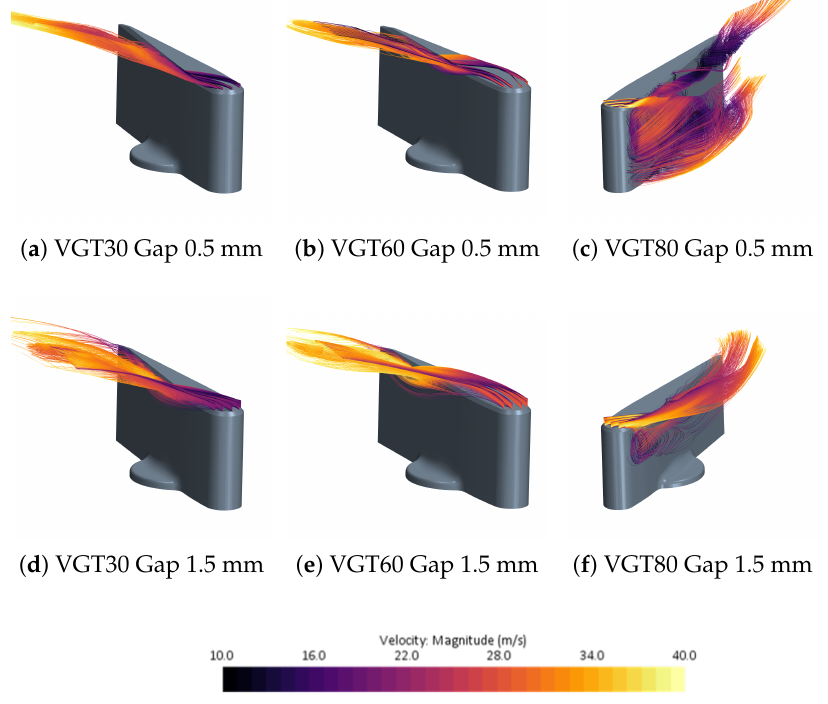
Figure 14. Tip gap vortex streamlines for two gap configurations and three vane openings. ST; VGT30, VGT60 & VGT80. 0.5 & 1.5 mm tip height.